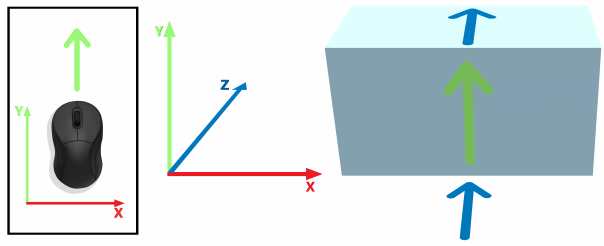
Figure 4. Mouse motion to 3D movement mapping.